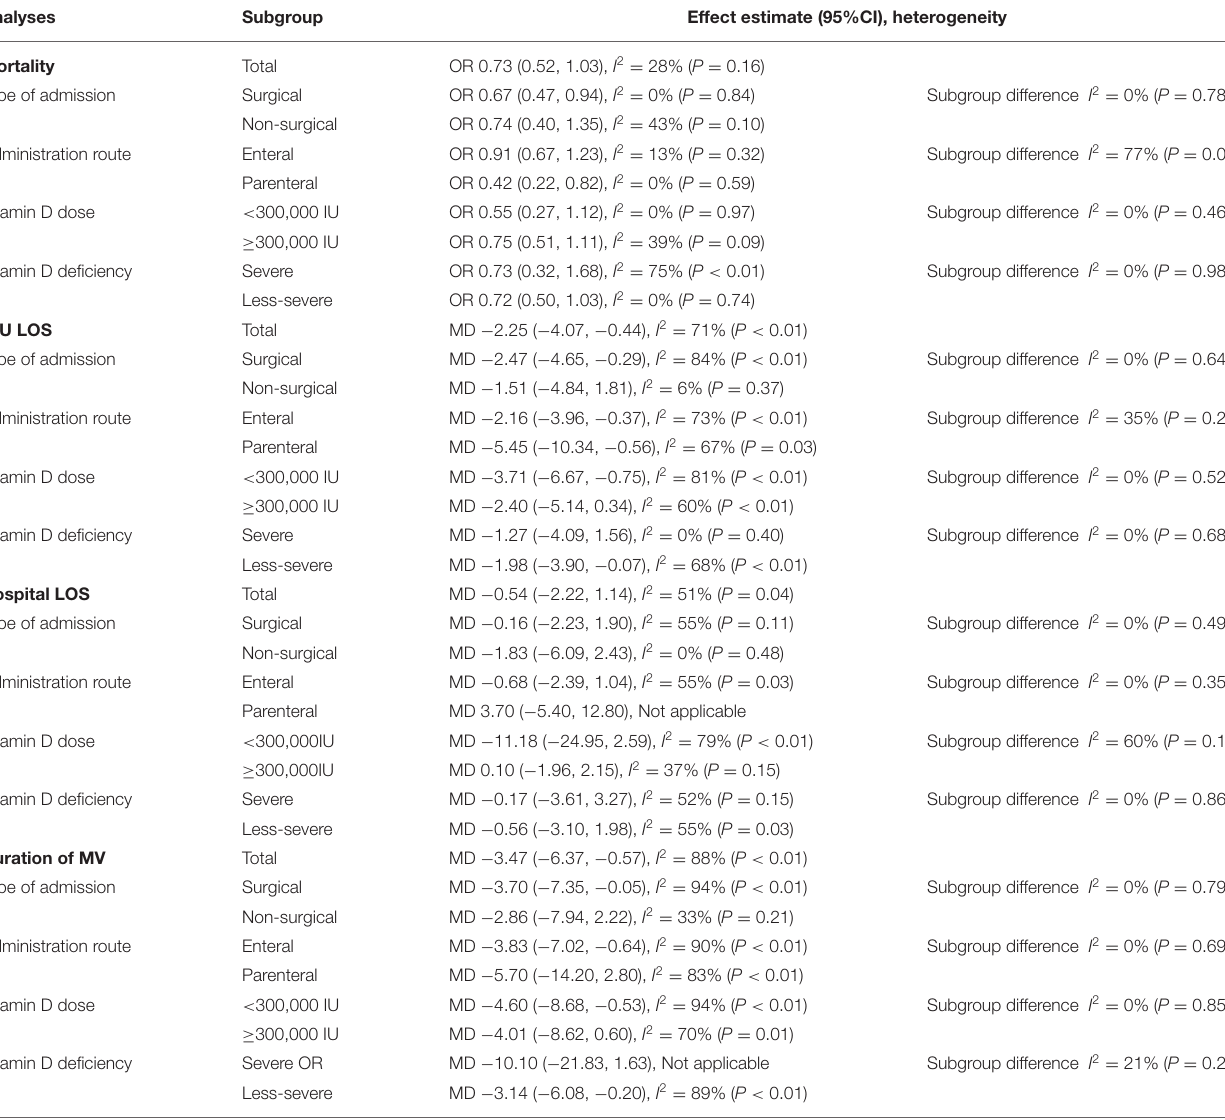
TABLE 2 | Main findings and subgroup analysis.